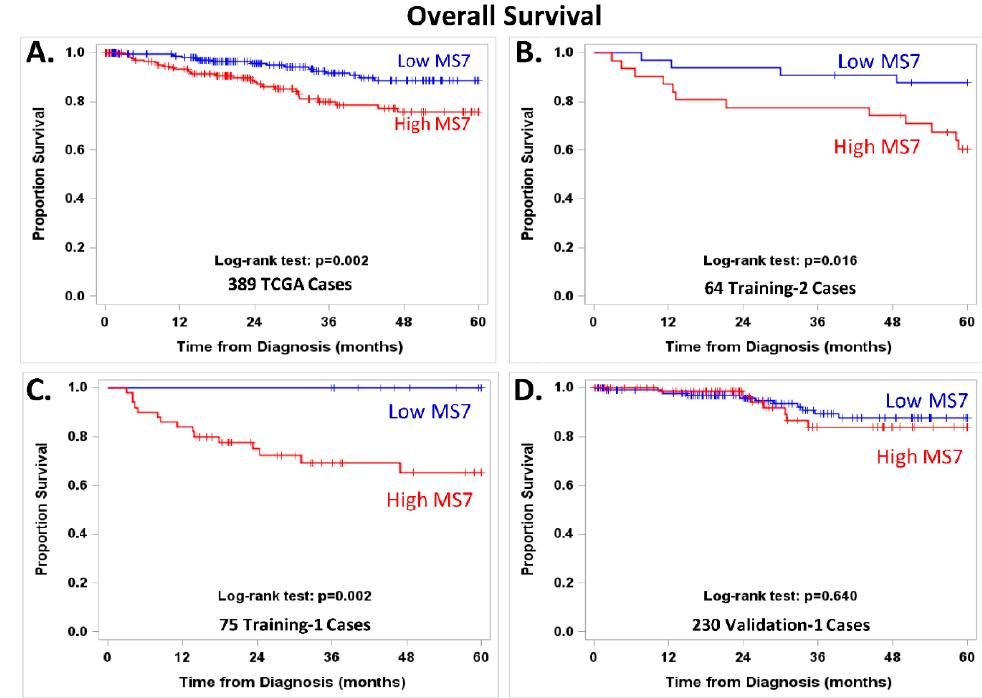
Figure 4. Overall survival plots were generated using the Kaplan–Meier method, and survival distributions were compared using log-rank tests for women with low (blue line) vs. high (red line) MS7 scores in 389 EEC patients with stage I-IV disease from the Cancer Genome Atlas Research Network (TCGA) ( A ); 64 EEC patients in the Training-2 cohort with stage I, IIIC, or IV disease ( B ); 75 EEC patients in the Training-1 cohort with stage I, IIIC, or IV disease ( C ); and 230 EEC cases from the Validation-1 cohort with stage I, IIIC, or IV disease ( D ). MS7 scores were categorized using the platform-centric cut points ( − 2.00356 for the RNAseq-based algorithm and − 4.25324 for the micro- array-based algorithm). The patients from the GYN-COE consortium in the Validation-1 and Valdi- ation-2 cohorts did not have follow-up data and were not included in the exploratory evaluation of MS7 and clinical outcome.